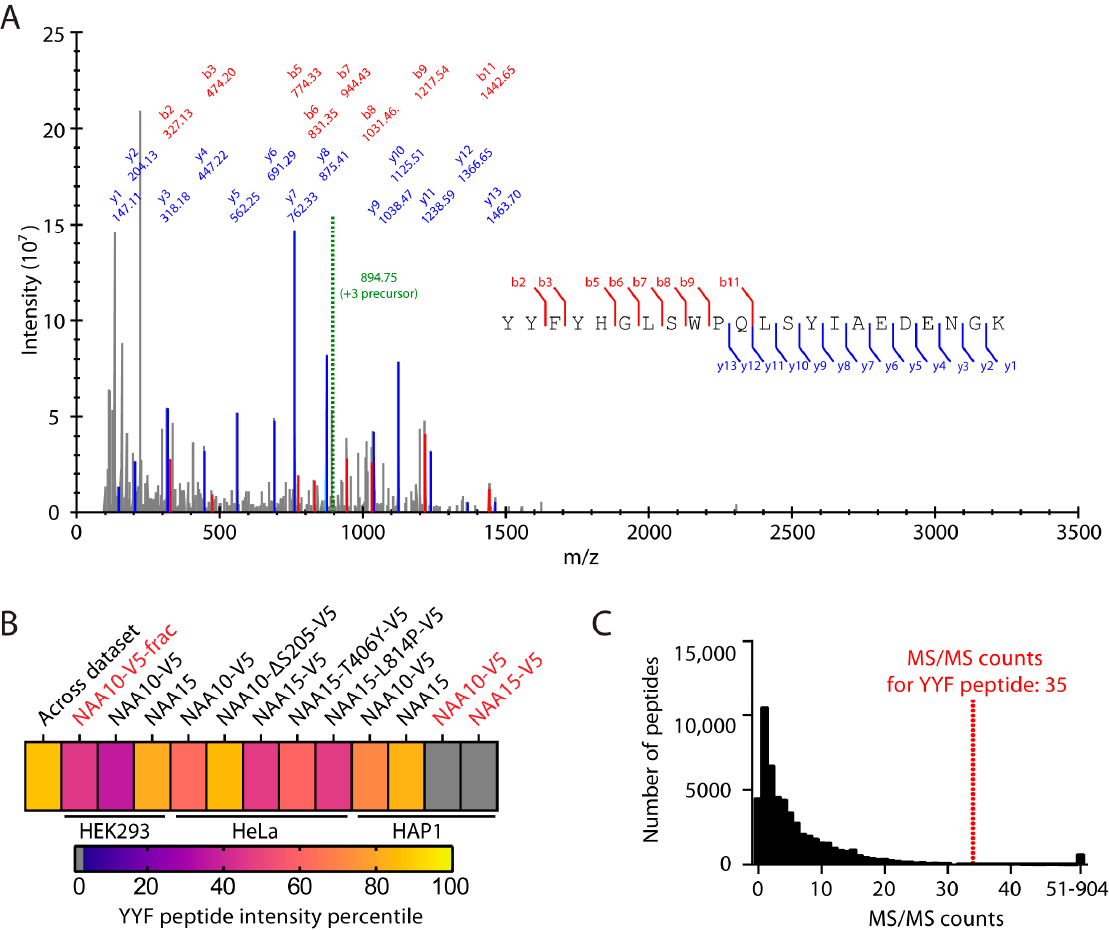
Figure 1. NAA10 is not hydroxylated at Trp38. ( A ) MS/MS spectrum of YYF peptide identified by MaxQuant and annotated in SeeMS. Green line: mass of precursor. Red: b ions. Blue: y ions. ( B ) Intensity percentile of YYF peptide in each sample analyzed by LC/MS. Red text: sample prepared by in-solution digestion. Black text: sample prepared by FASP. ( C ) Histogram of MS/MS counts among the identified peptides across the dataset. Further, it was claimed that NAA10 and FIH interact. In the NAA10 IP samples ana- lyzed by mass spectrometry, we did not find any FIH peptides (Table S4). Note that FIH has been previously shown to be expressed in HEK293 [65,68], HeLa [68], and HAP1 cells [69]. We performed immunoblotting for FIH in each cell type and verified that this was the case (Figure 2A). To enable comparisons between LC/MS runs collected under differ- ing conditions, we ranked protein groups using an intensity-based absolute quantification (iBAQ [70]) value for each sample and found the percentile score for each of the NatA complex subunits (Figure 2B). For the NAA10- and NAA15-enriched samples, NAA10 and NAA15 were usually in the top 10% most abundant proteins. This included the rea- nalysis of the LC/MS runs from a previous paper describing the NAA15-T406Y and NAA15-L814P variants, with the T406Y mutant having a significantly reduced binding to NAA50, and the L814P mutant being somewhat deficient in binding HYPK [71]. We found no FIH peptides at all in our dataset even though we could find the three other known